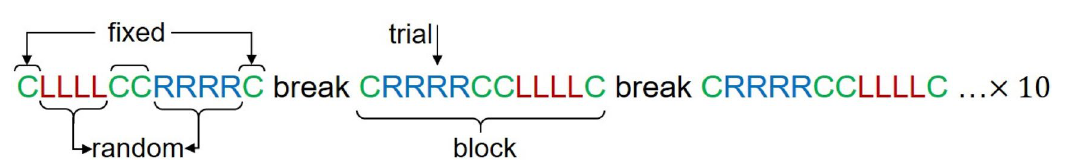
Figure 8. Generation of block and condition order for participants. Each participant did 10 blocks of 12 trials (4 for each VR location condition). Center trial positions were fixed while the right and the left set of four trials were randomly distributed between the center